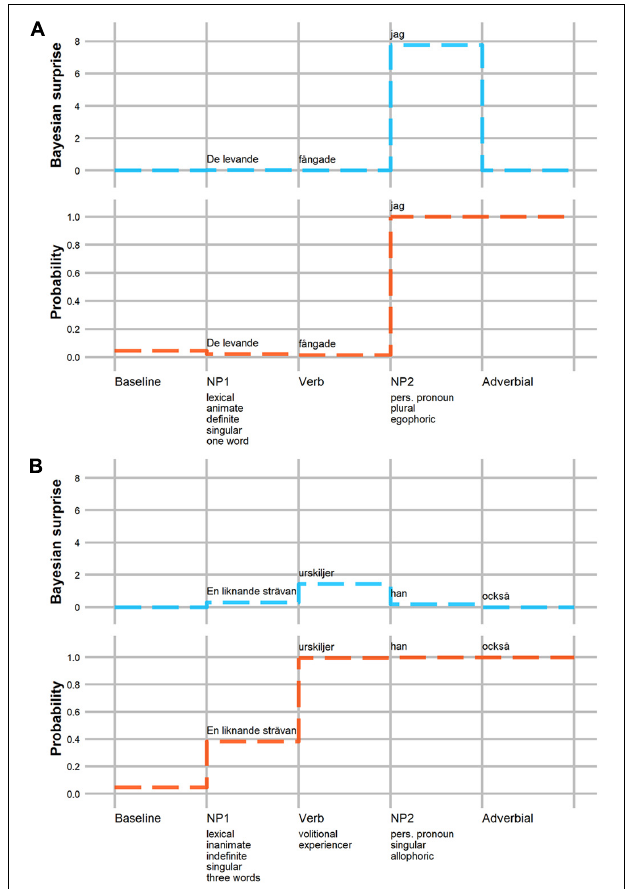
FIGURE 2 | Model-predicted probability of OS order (bottom of each panel) and Bayesian surprise (top) for two example sentences from the corpus. Panel A: information that disambiguates the sentence toward OVS order is provided at NP2. Panel B: information that speaks in favor of OVS order accrues over the sentence constituents. The relevant cues of each sentence are specified on the